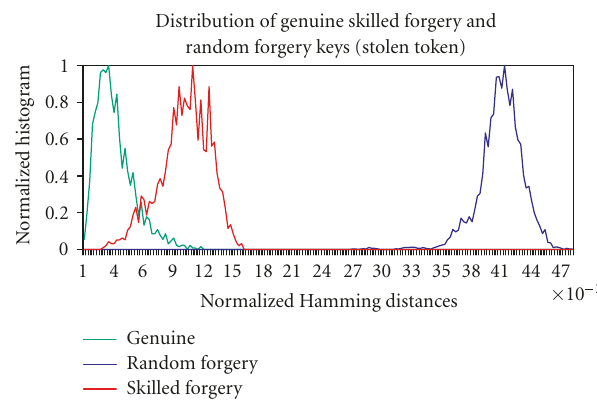
Figure 5: Hamming distribution for stolen token scenario k ind = 1.